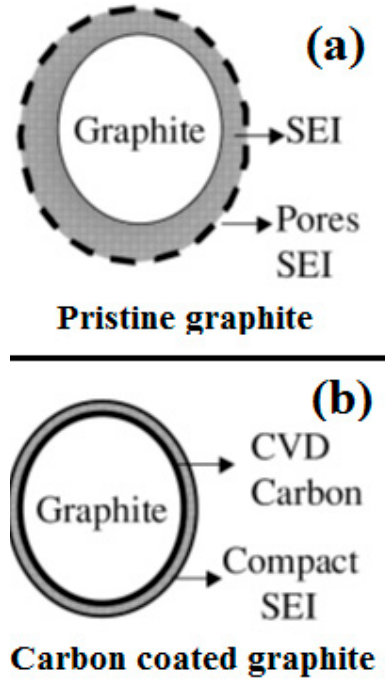
Figure 12. Schematic of the SEI layer on ( a ) pristine and ( b ) carbon coated graphite. Adapted with permission from [138], © Elsevier, 2001.